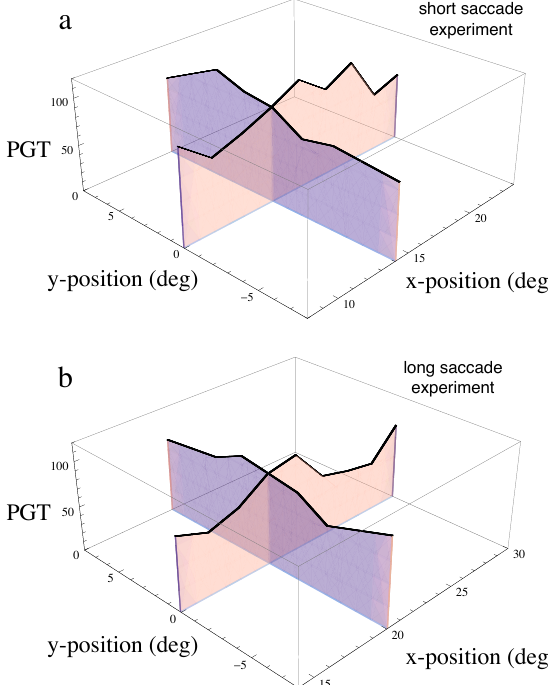
Figure 8 . Percent gain transfer for saccades to testing po- sitions which share almost the same vertical and horizontal components as the adapted 14 deg saccade (a) or the adapted 20 deg saccade (b). The brighter surface indicates the hori- zontal component and the darker surface the vertical compo-